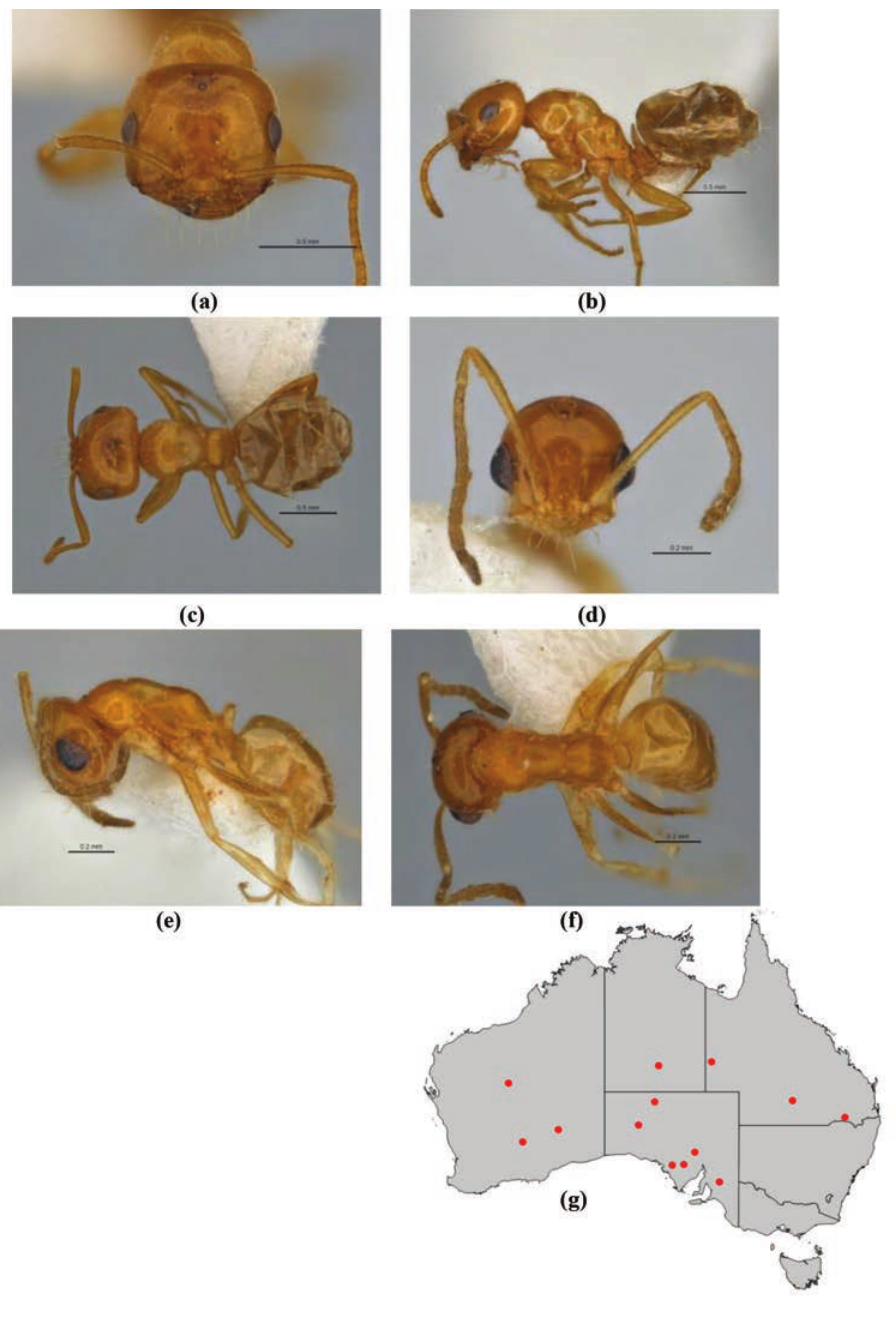
Figure 93. Melophorus pusillus sp. n.: major worker paratype (JDM32-004668–top ant) frons ( a ), pro- file ( b ) and dorsum ( c ); minor worker holotype (JDM32-004668–bottom ant) frons ( d ), profile ( e ) and dorsum ( f ); distribution map for the species ( g ). Low resolution scale bars: 0.5 mm ( a–c ); 0.2 mm ( d–f